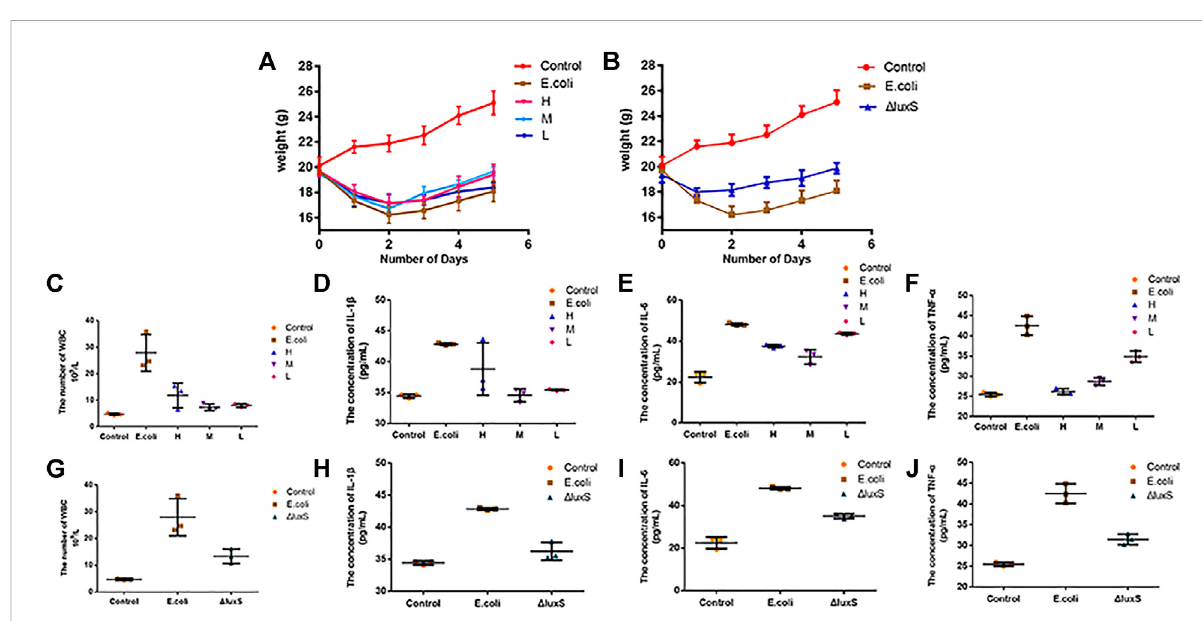
FIGURE 7 Effect of Escherichia coli on body weight and in fl ammatory factors in mice. (A) Body weight changes in mice with bacterial diarrhea after treatment with various dosages of 1,8-cineole. (B) The effect of E. coli O101 without luxS gene on mice body weight. (C – F) Changes in the concentrations of leukocytes and in fl ammatory factors (IL-1 β , IL-6, and TNF- α ) in mice with bacterial diarrhea after treatment with different concentrations of 1,8-cineole. (G – J) Changes in leukocyte and in fl ammatory factors concentrations in mice infected with E. coli O101 without luxS gene. The results represent means ± standard deviations for three independent experiments. * p < 0.05, ** p < 0.01 and *** p < 0.001 versus the control